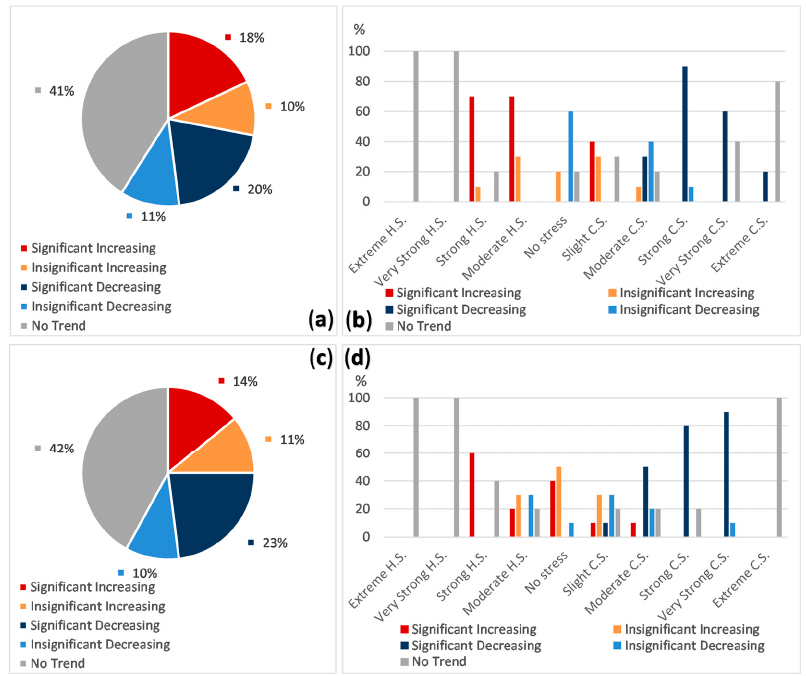
Figure 12. Trend types for the UTCI index: ( a ) for all data sets of FO; ( b ) by thermal sensations classes of FO; ( c ) for all data sets of DOP; ( d ) by thermal sensations classes of DOP. As a spatial distribution, the DOP seemed to increase significantly for the strong heat s tress in the western and southern regions of the country; for the other regions, no change was detected.